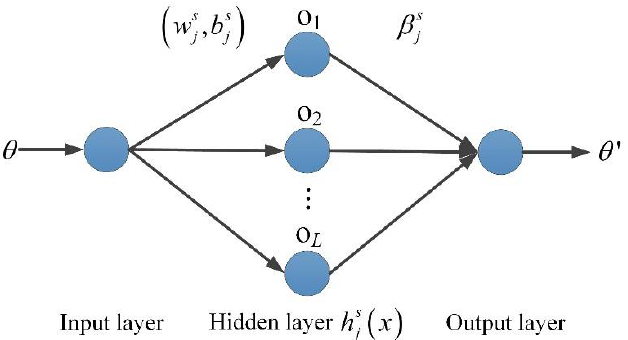
Figure 6. OS-ELM-AP-based interference angle prediction